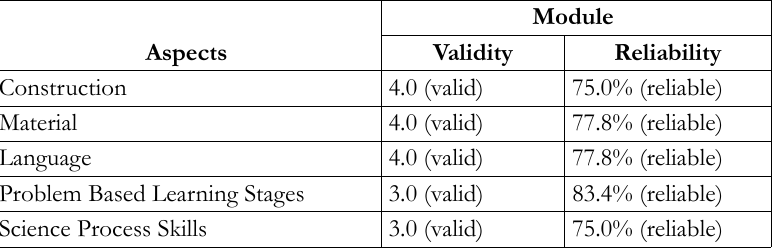
Table 4. The validity of the case study-based